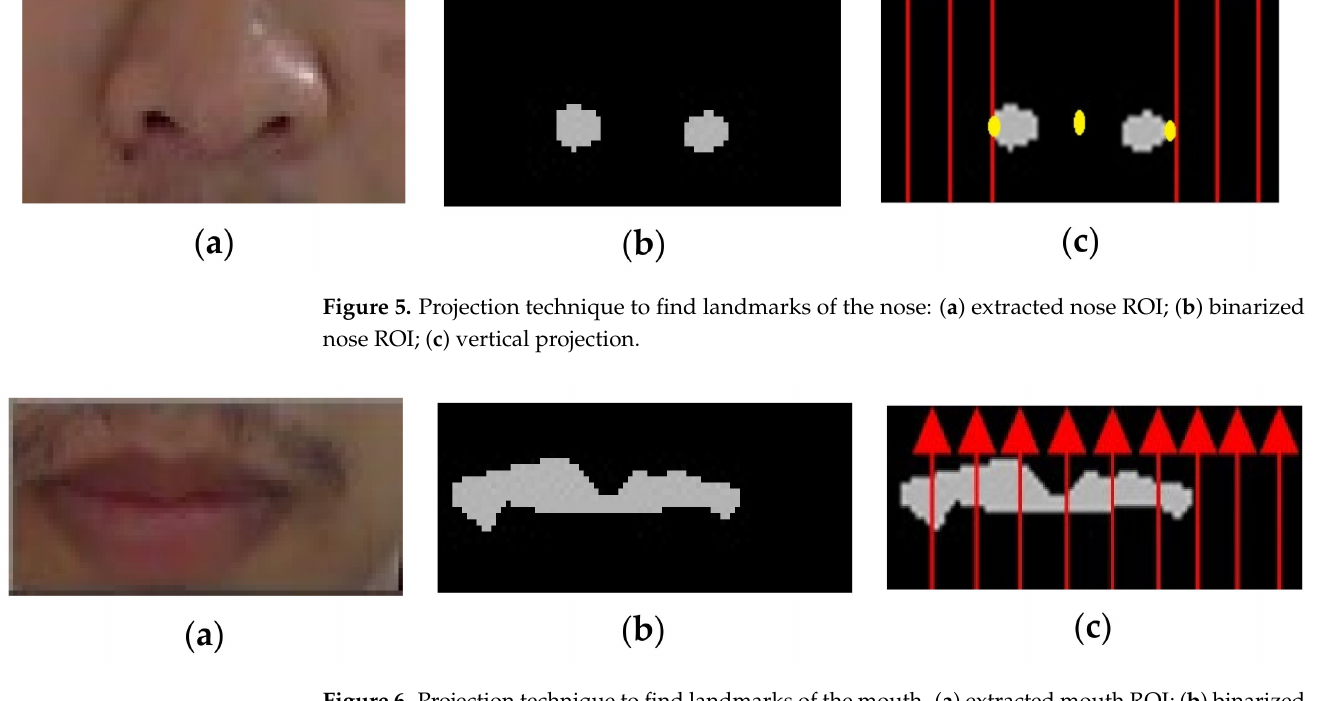
Figure 6. Projection technique to find landmarks of the mouth. ( a ) extracted mouth ROI; ( b ) binarized mouth ROI; ( c ) vertical